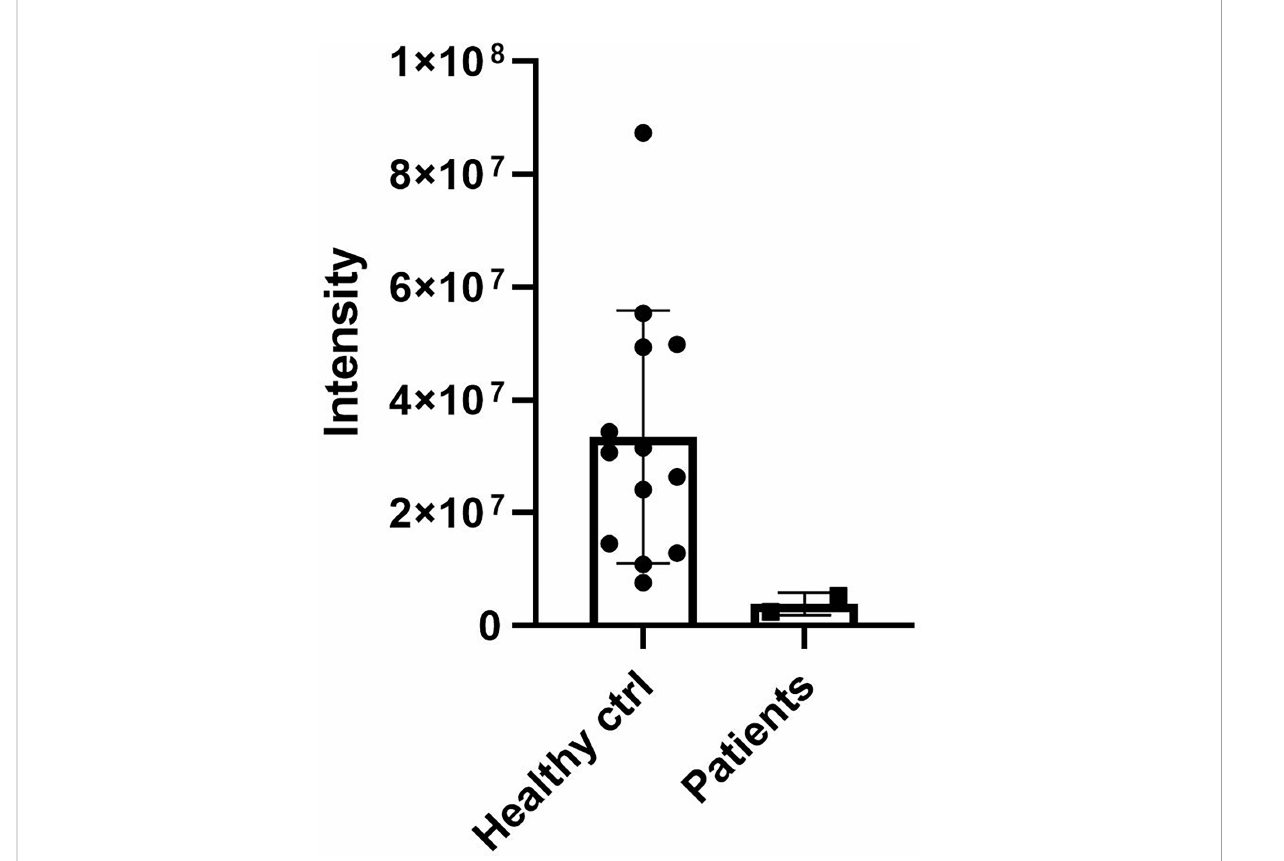
DCD. The graph shows the relative abundance of DCD peptide in sweat samples. Results represent the mean of three technical replicates for each sweat sample ±SD.